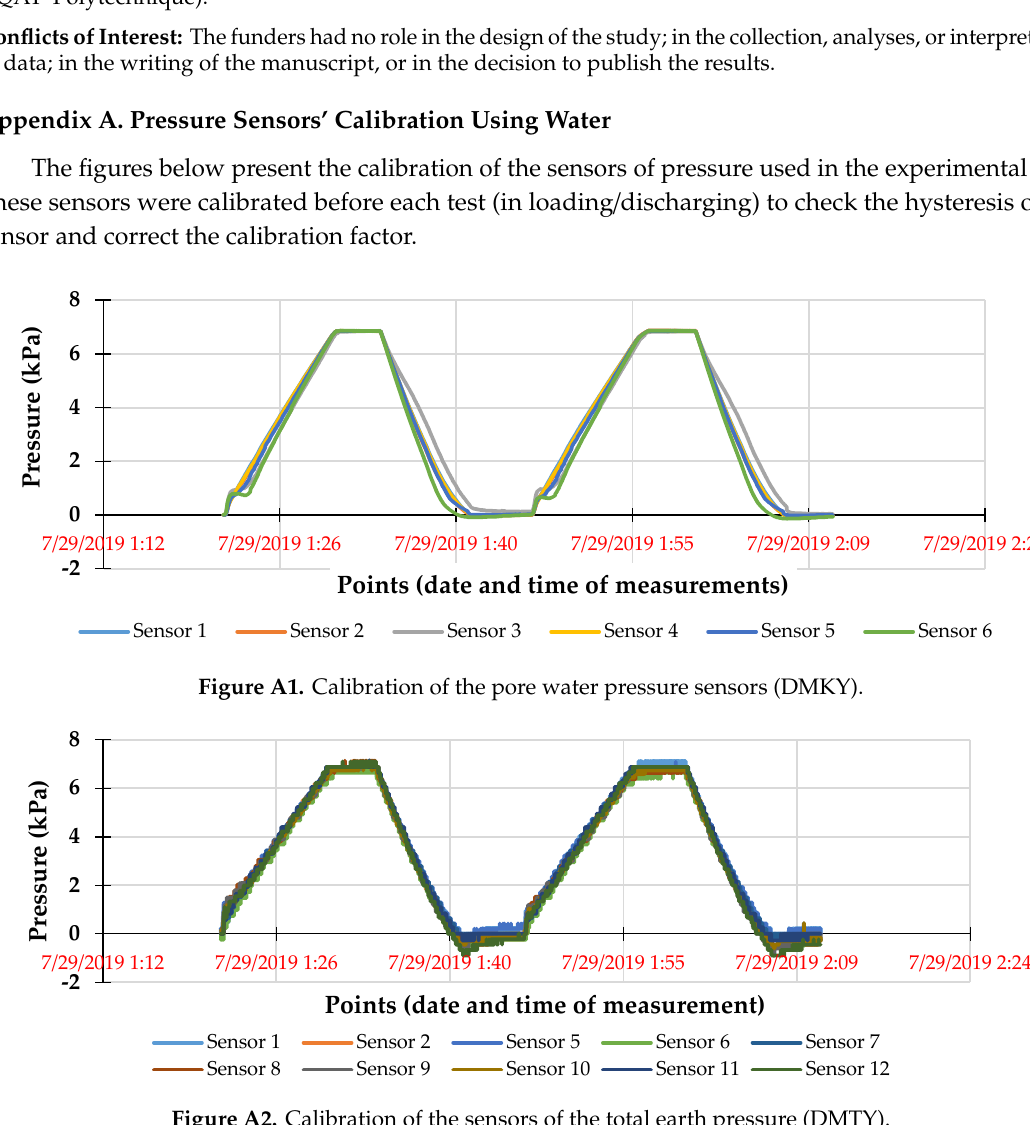
Figure A3. Calibration of the sensors of the total earth pressure at the face of the barricade (PS-D). Appendix B. Cemented Paste Backfill Preparation The required total mass of dry tailings ( 𝑀 𝑡 ) in the backfill mixture is given by: 𝑀 𝑡 =